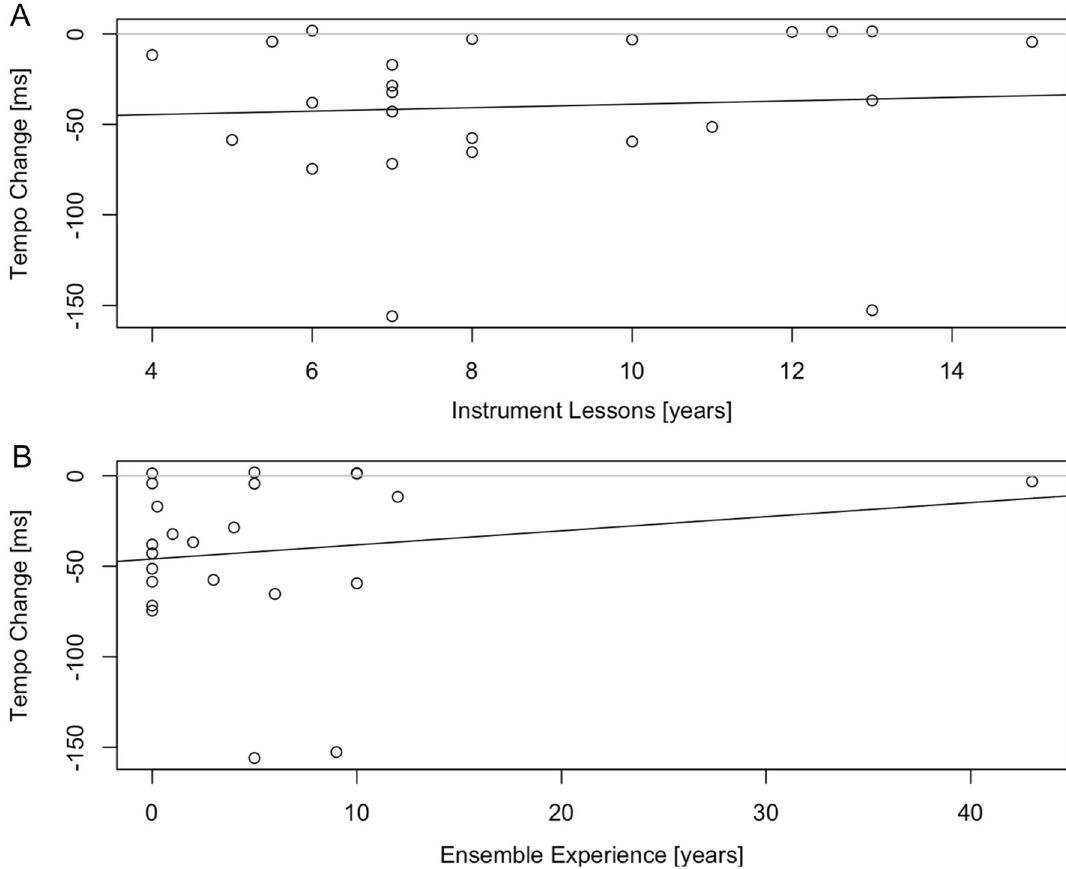
Figure 5. Each musicians’ tempo change as a function of years of private lessons on their main instrument ( A ) and years of experience with ensemble playing ( B ). The black lines represent the results of the corresponding linear regressions. Neither regression was